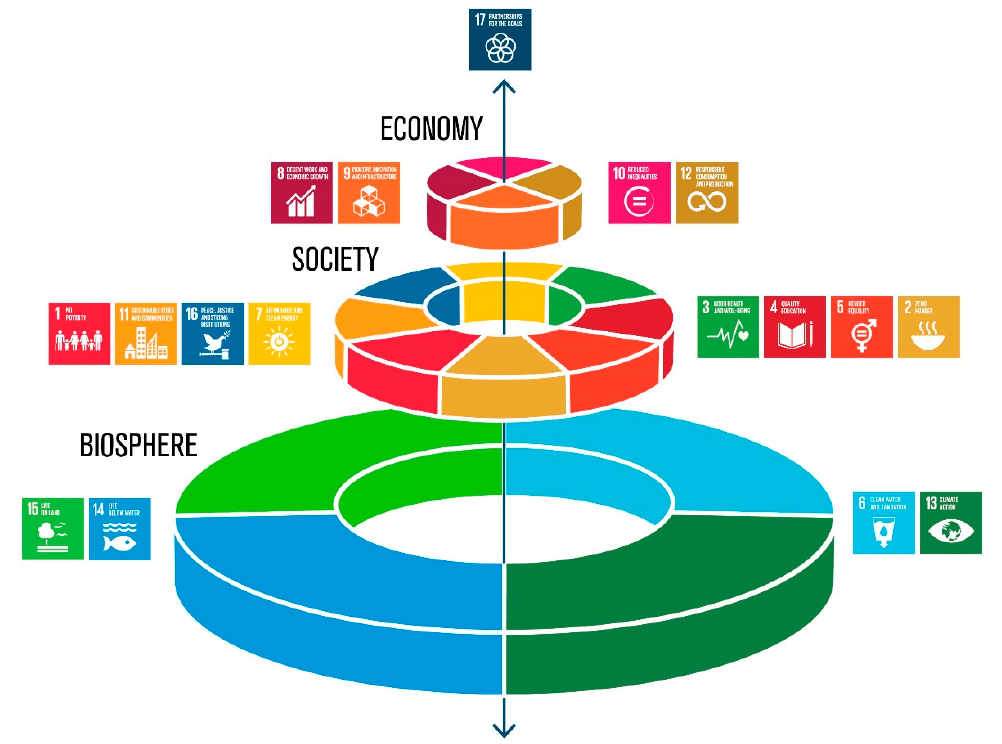
Figure 1. Relation of different domains within the Sustainable Development Goals (SDGs), biosphere, society, and economy. SDG15 is one of the four goals making up the biosphere ring (adapted after the original figure of the Azote Images for Stockholm Resilience Centre).